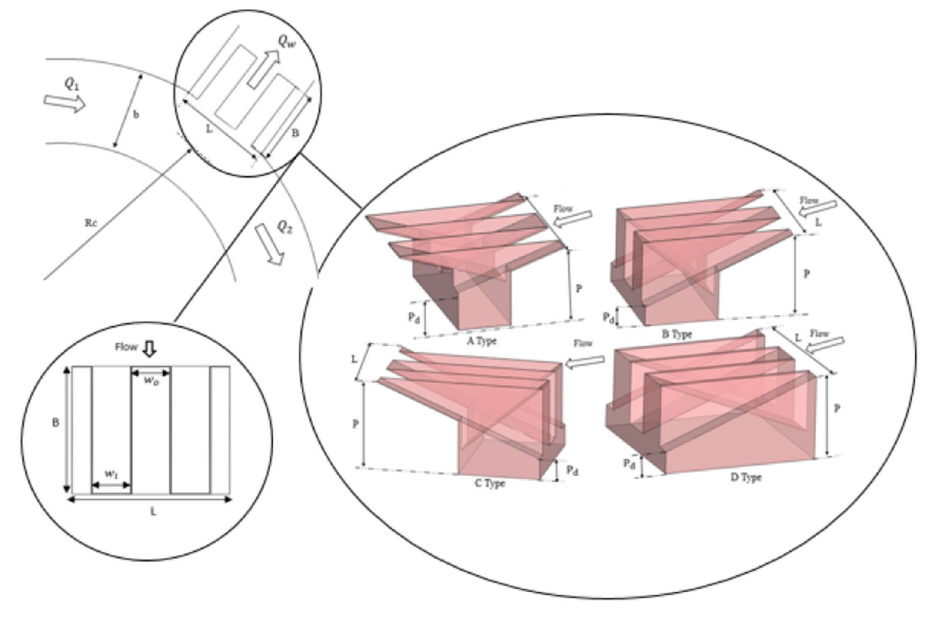
Fig. 5 Weirs used in the labora-